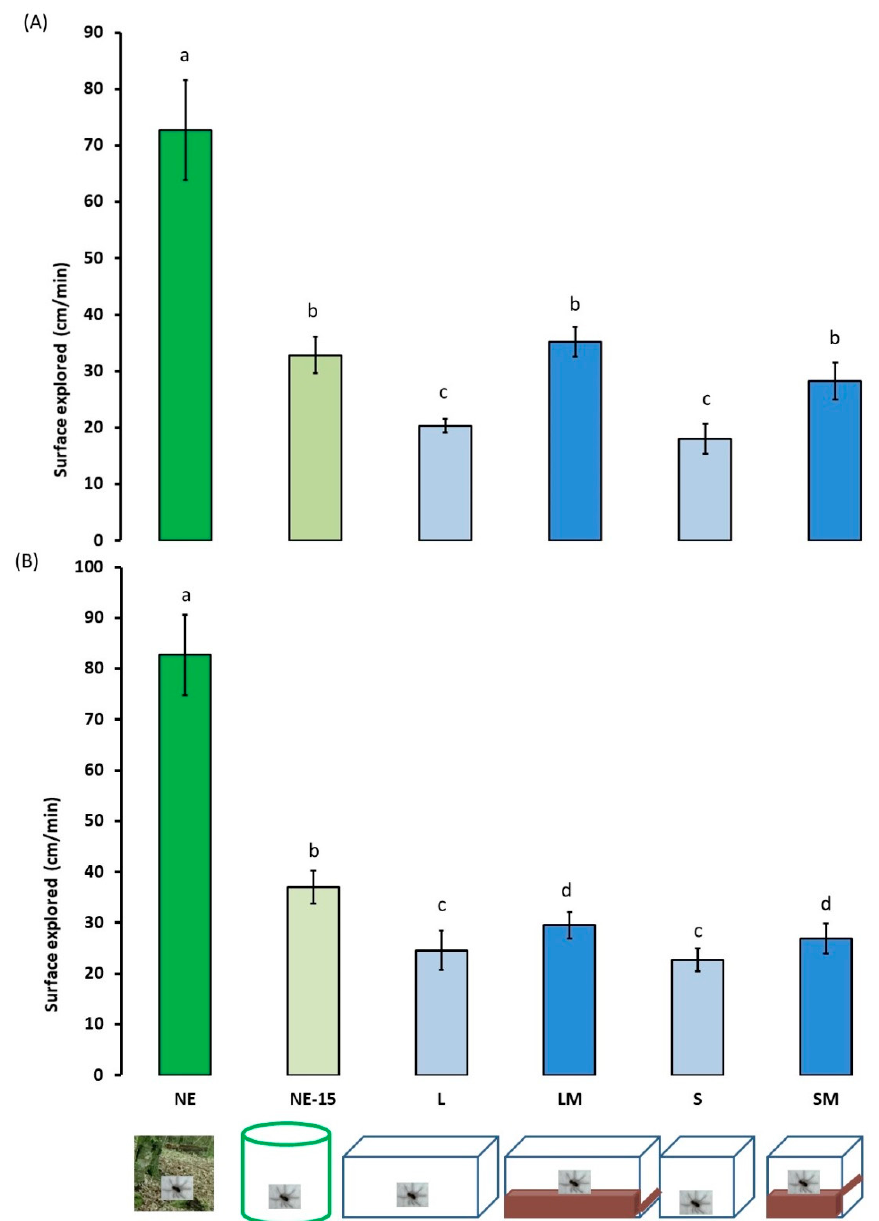
Figure 7. Locomotor activity ±95% confidence intervals (expressed in surfaces explored, cm/min) of adult female ( A ) and male ( B ) Pardosa saltans in a open-field arena in relation to the environment where they developed: (NE) in their natural environment and tested 2–3 h after capture; (NE-15) in their natural environment and tested after 15 days in captivity; (L) in the laboratory in large terraria without matter on the base; (LM) in the laboratory in large terraria with matter on the base; (S) in the laboratory in small terraria without matter on the base; (SM) in the laboratory in small terraria with matter on the base. Data were compared using generalised linear mixed mod (GLMM, negative binomial distribution). Different letters indicate a significant difference ( p < 0.050, post hoc Wald